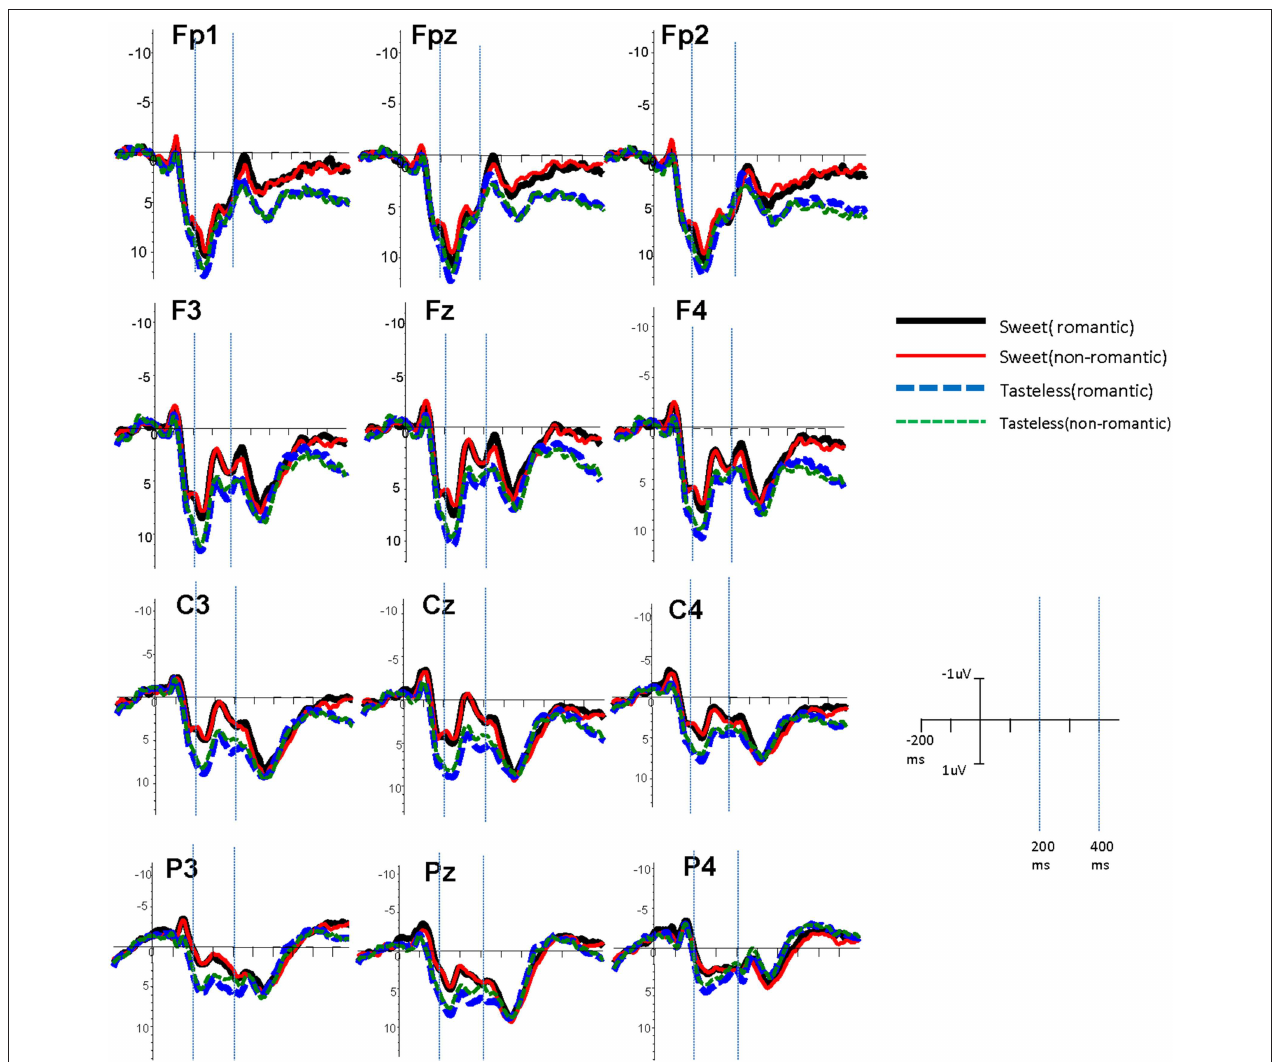
FIGURE 2 | Grand average waveforms showing the romantic and non-romantic words processed in different taste conditions.